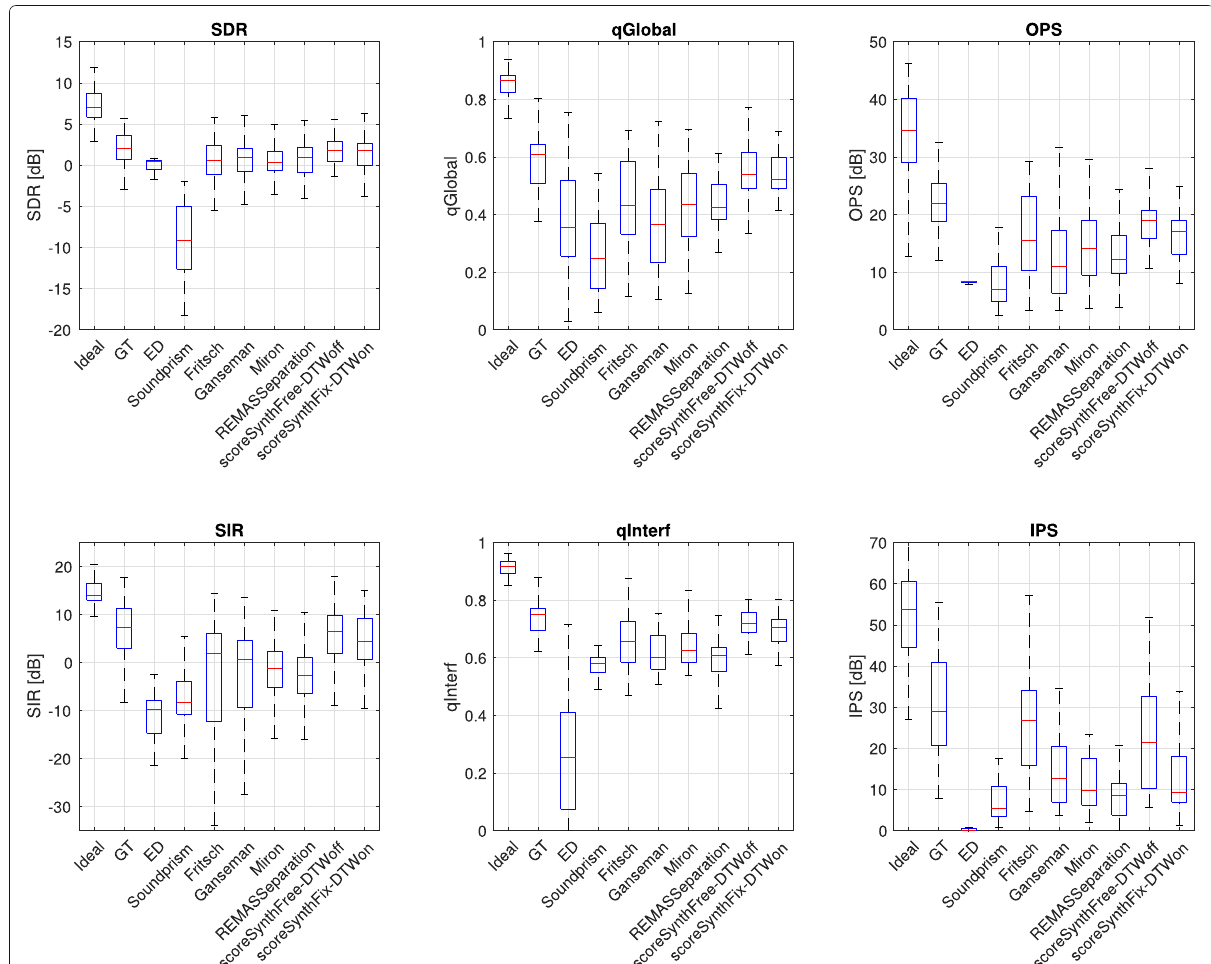
Fig. 8 Objective and perceptual results for the comparison of the SS methods using the BBS_EVAL metrics and the PEASS metrics for the orchestra